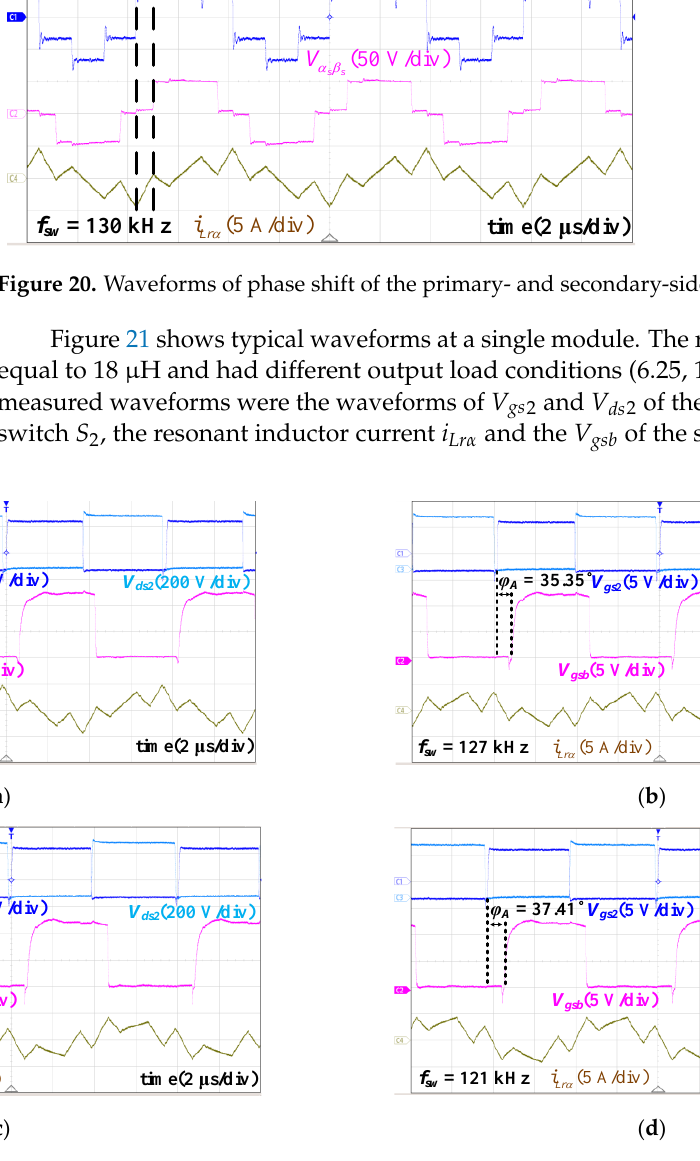
Figure 21. Typical waveforms at ( a ) 25%, ( b ) 50%, ( c ) 75% and ( d ) 100% loads. The values of resonant inductors L rA and L rB were set at different values to test imbal- anced current conditions. L rA was designed as 20 µ H and L rB was 16 µ H. Figure 22 shows the output current waveforms of the two modules in parallel at a 25% load conduction. Figure 22a,b show without and with a current sharing control. When the function of the current sharing control was disabled, the current was imbalanced due to component mismatch. With a PSM control, the imbalanced current was improved. Both ripple current frequencies of i oA and i oB were six times larger than the switching frequency. Furthermore, with phase lagging ϕ AB at 30 ◦ , the ripple current frequency of i o was twelve times larger than the switching frequency, achieving a minimum output ripple current i o_pp The trend of switching frequency and phase shift changing was the same as Figure 13 in that when the load was increased, the switching frequency f sw decreased and the phase shift degree φ A increased.